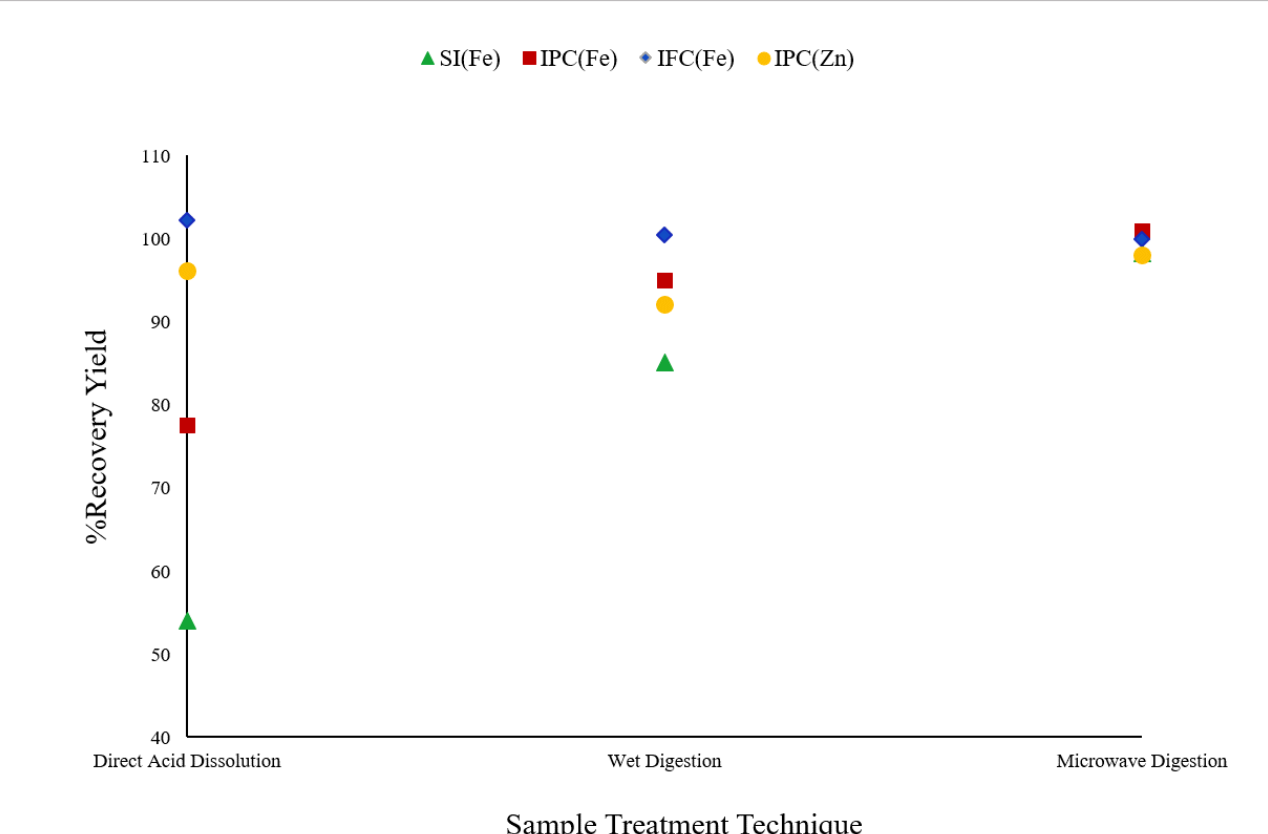
FIGURE 2 - Iron and zinc recovery dependence on the sample preparation technique (n = 9). Delay: 5 s, Measurement: 5 s. For the microwave-digested and wet digested samples %RSD was less than 0.8%, while for the directly dissolved samples, the %RSD was less than